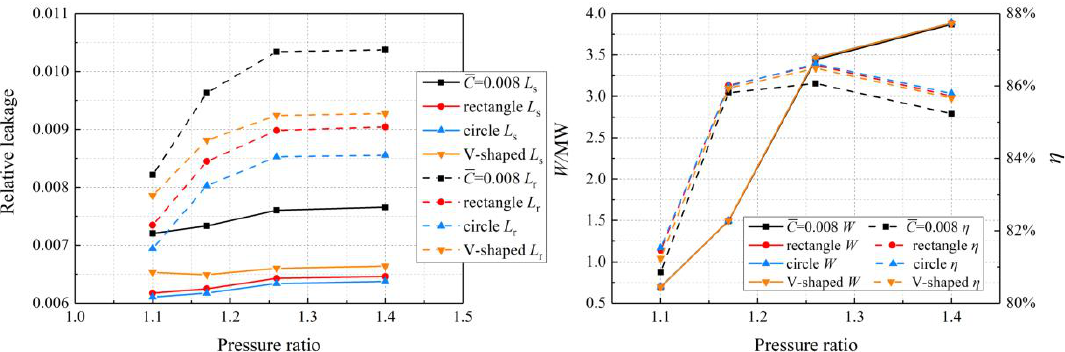
Figure 14. Variations of performance parameters under different groove on cavity surface with pressure ratio (left: relative leakage; right: power and efficiency). Table 5. Configurations of circle grooves.